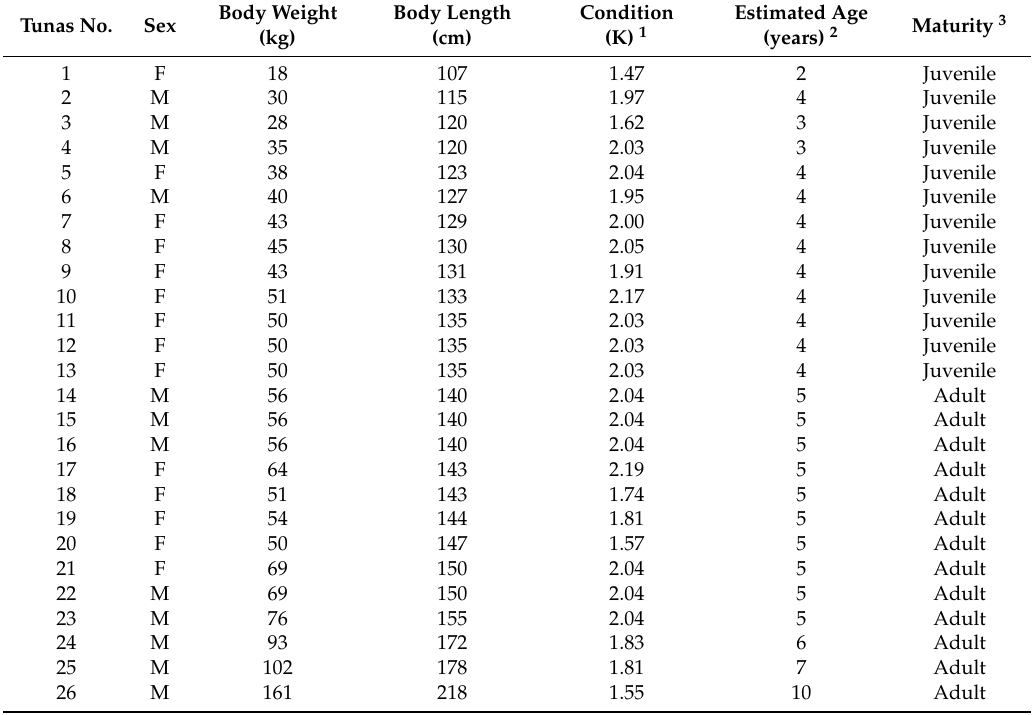
Table 1. The biological data of The Bluefin tunas